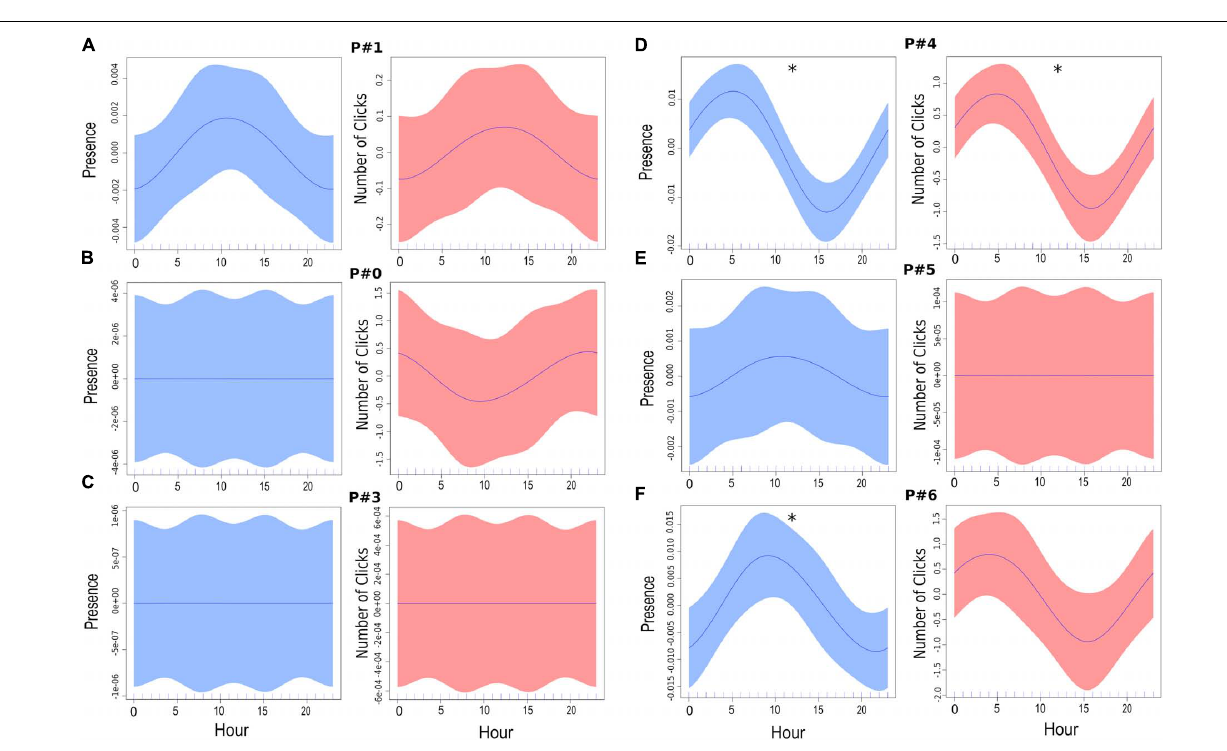
FIGURE 10 | Daily patterns. Plots showing smoothing estimators of GAMMs with hour of the day as fixed effect and knots capped at four smooths. The shaded areas represent the 95% confidence intervals. For each site (A–F) , click presence is shown in blue ( left ) and number of clicks is shown in red ( right ).